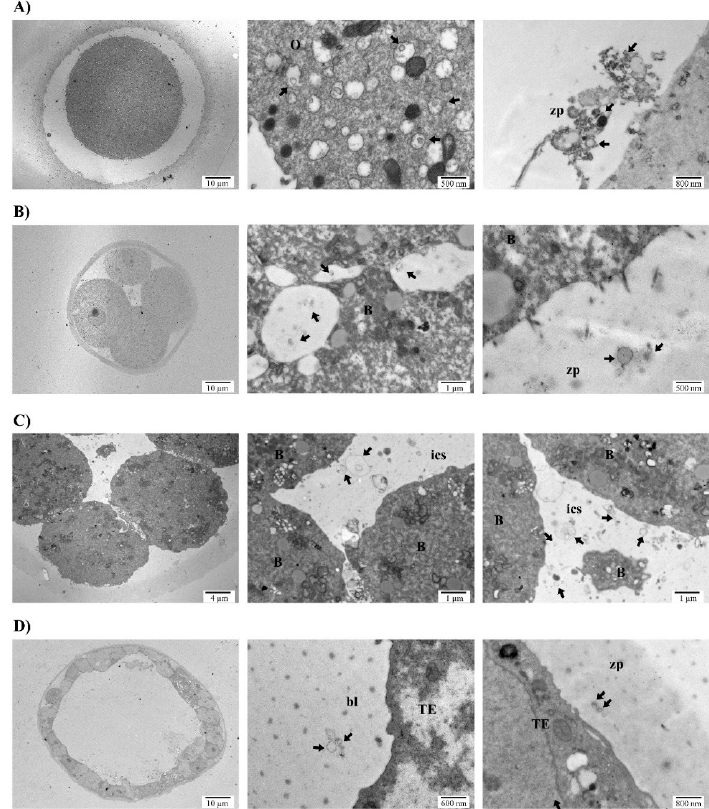
Figure 1. Vesicle production and secretion by murine embryos at different developmental stages shown by TEM. ( A ) Mouse oocyte (left) with magnifications of the production of multivesicular bodies (MVBs) in the cellular cytoplasm (center) and secretion of their content towards the zona pellucida (right). ( B ) E2.5 embryo (left) with magnifications of the cytoplasm containing MVBs (center) and the secretion of extracellular vesicles (EVs) through the zona pellucida (right). ( C ) E3.5 mouse embryo (left) showing MVB secreted to the intercellular space. ( D ) E4.5 blastocyst (left) secreting EVs into the zona pellucida (center) and blastocoel cavity (right). Abbreviations: B, blastomere; bl, blastocoel; O, oocyte; TE, trophectoderm cell; zp, zona pellucida.